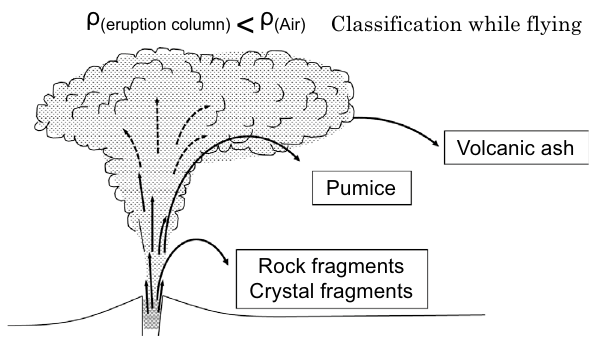
Fig. 25 Diagram of Plinian eruption